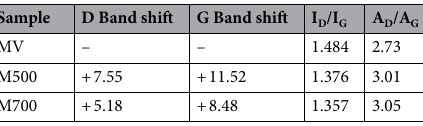
Table 3. Raman spectroscopy data of the